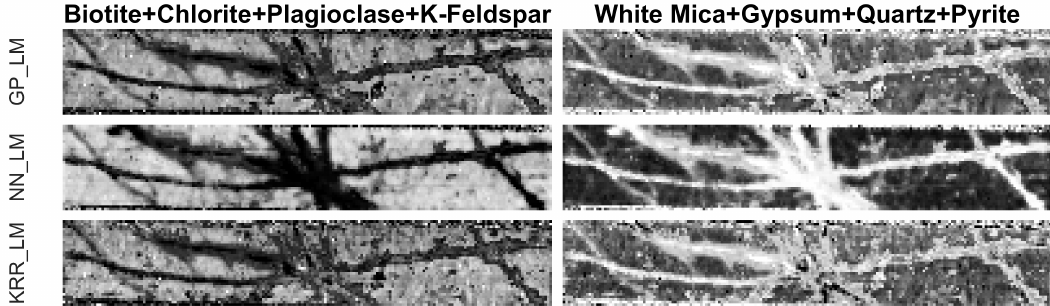
Figure 14. Estimated abundance maps (without rescaling) of the entire drill core sample, for groups of minerals representing the matrix ( left ) and veins ( right ) (applying a map learned by using 373 training